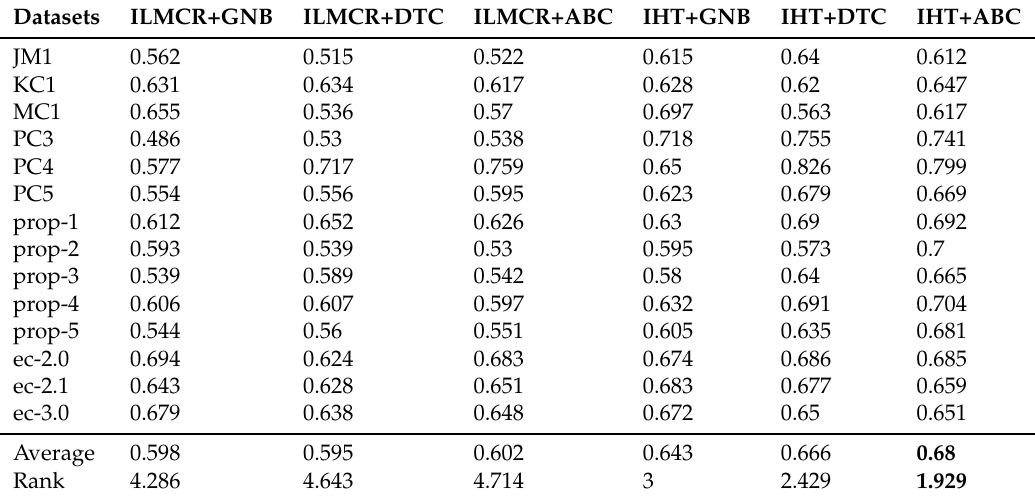
Table 17. Balancedscore of matching of classifiers with LIMCR and IHT on large datasets.